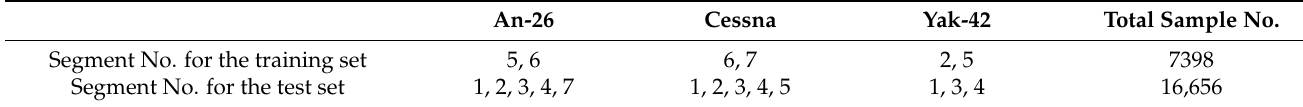
Table 3. Division of the data set and number of samples. An-26 Cessna Yak-42 Total Sample